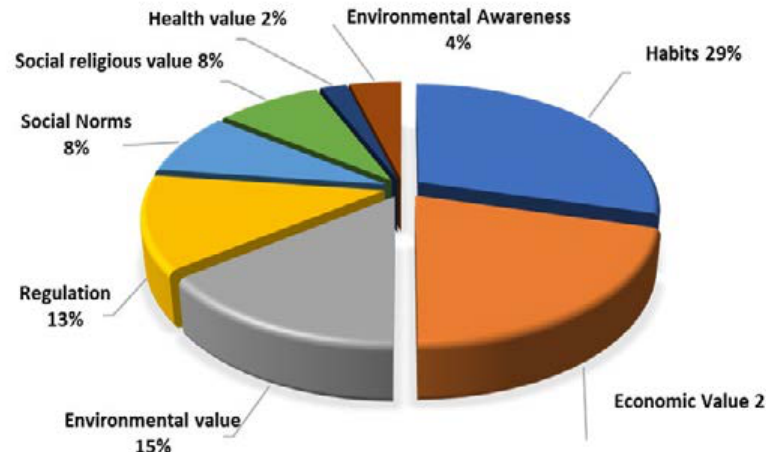
Fig. 4: The driving force of residents’ participation in KBS program